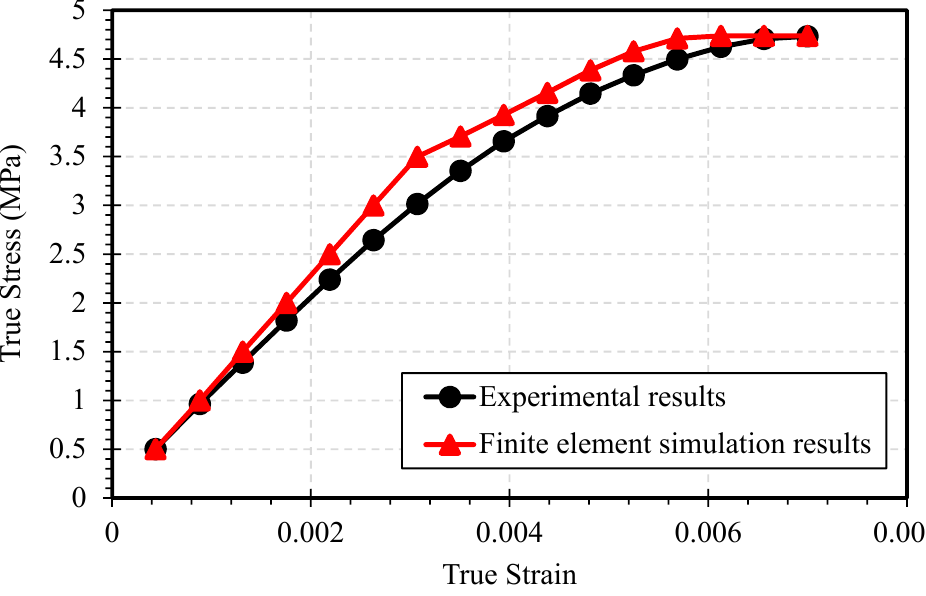
Figure 9. Plot of True Stress vs True Strain for experimental and finite element simulation of tension test.